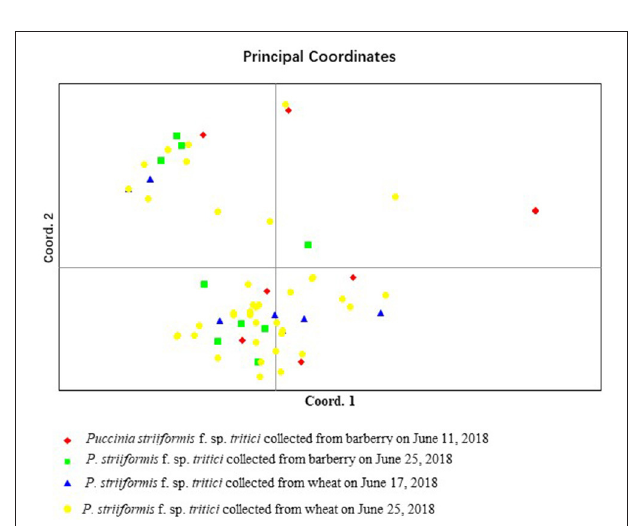
FIGURE 6 | Principal coordinates analysis (PCoA) based on the calculated virulence differences between each of Puccinia striiformis f. sp. tritici isolates. The first axis represents 43.22% and the second represents 17.44% of the total virulence differences between the individual